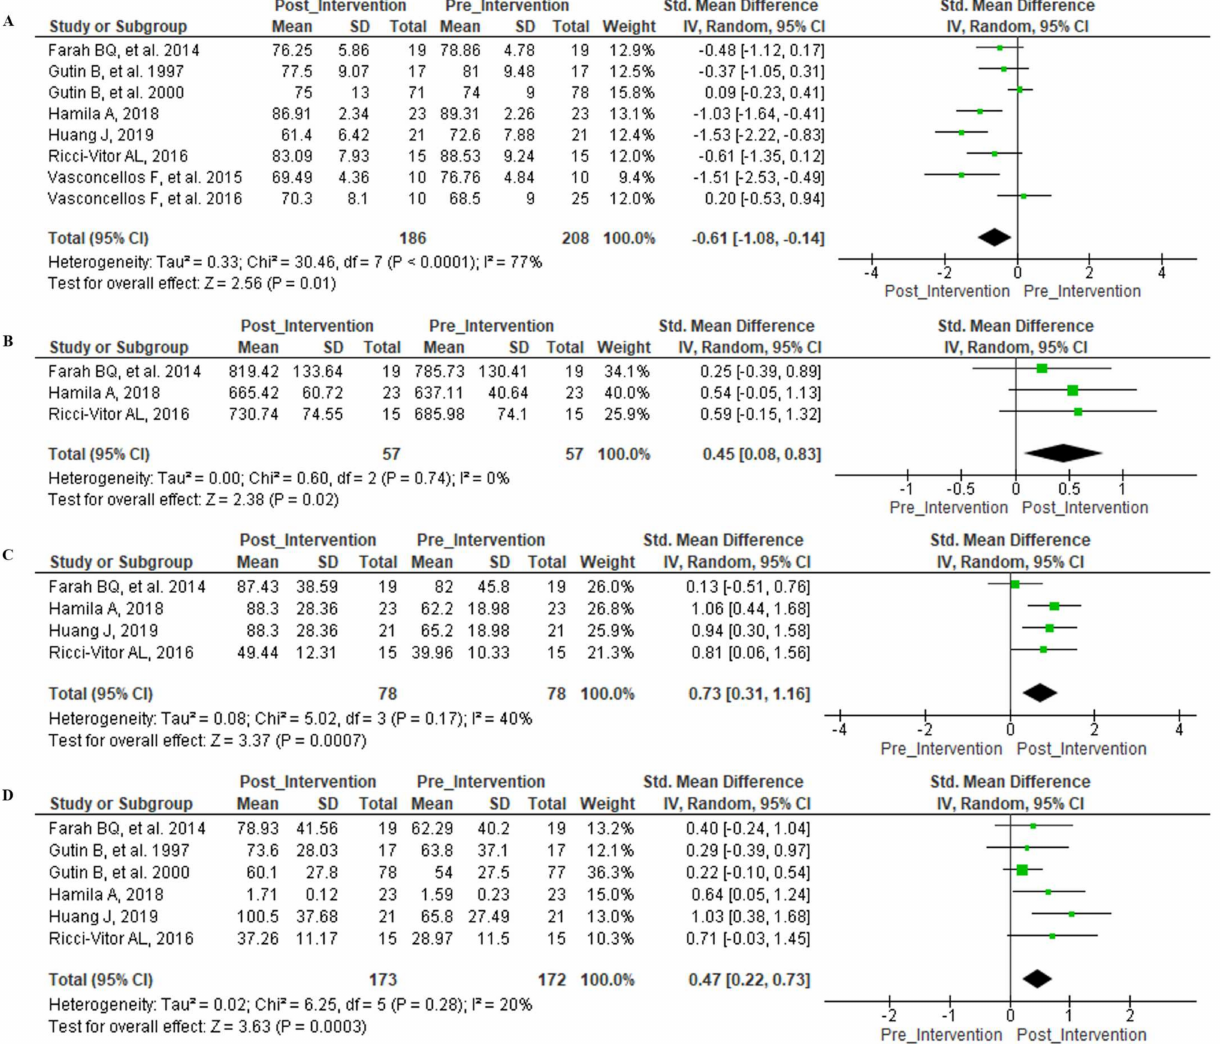
Figure 2. Forest Plot—Time domain indices. Legend—( A ): Mean Heart Rate mean; ( B ): R-R interval; ( C ): SDNN; ( D ):